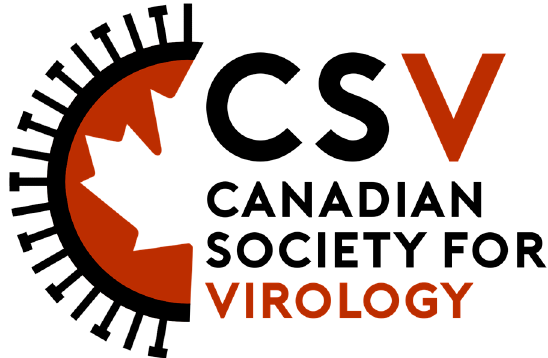
Figure 1. Canadian Society for Virology logo (art by Lucas Jarche, Dalhousie University, Halifax, NS, CA).